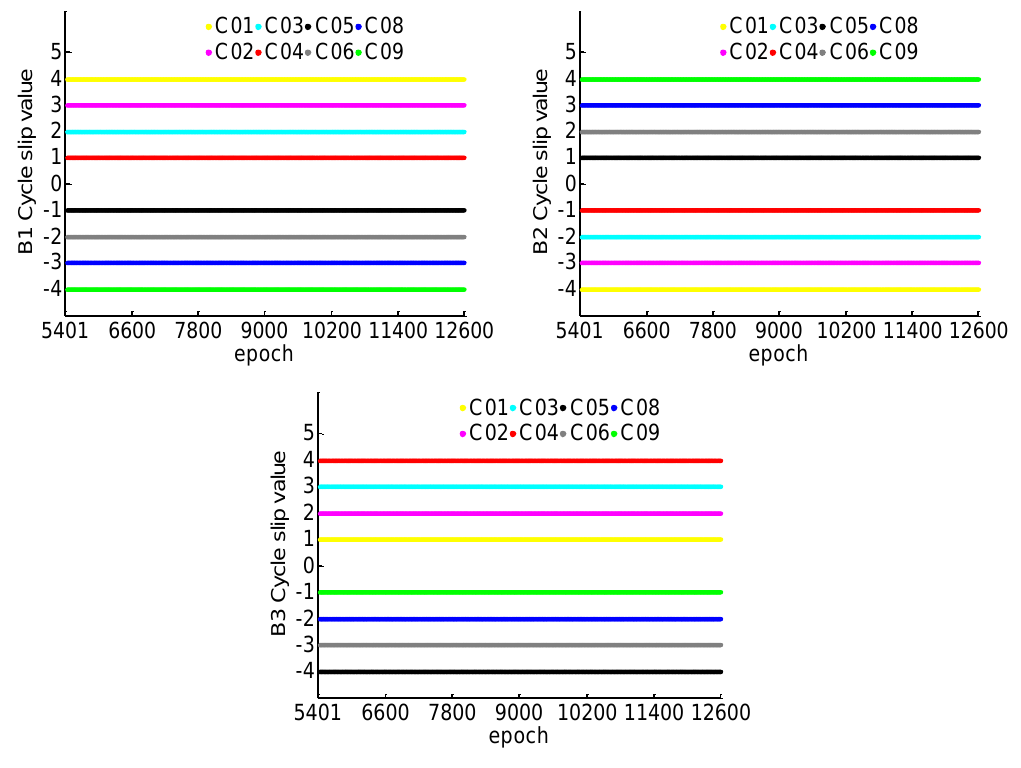
Figure 2. Introduced cycle slip on B1, B2, and B3.